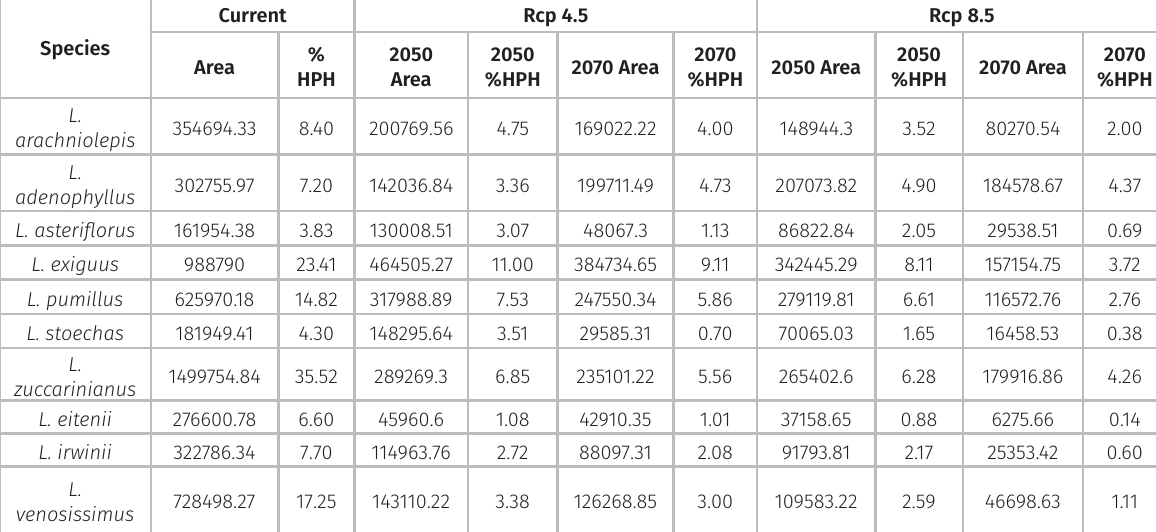
Table III. Area (in Km 2 ) and percent of the total studied area considered as optimal potential habitat of Lessingianthus species fo current and future models. %HPH: percent of high potential habitat. Total area studied: 4.22 km 2